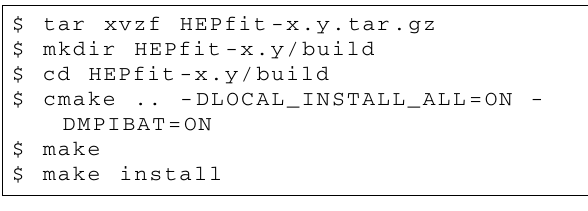
Fig. 4 The correlations between the ratio of the penguin and tree con- tributions, P / T , and the CP asymmetries (given in %). HFLAV world average of (cid:5) A CP has been used for the fit and these CP asymmetries correspond to the negative solution for the phases. The orange, red and green regions are the 68%, 95% and 99% probability regions respec-